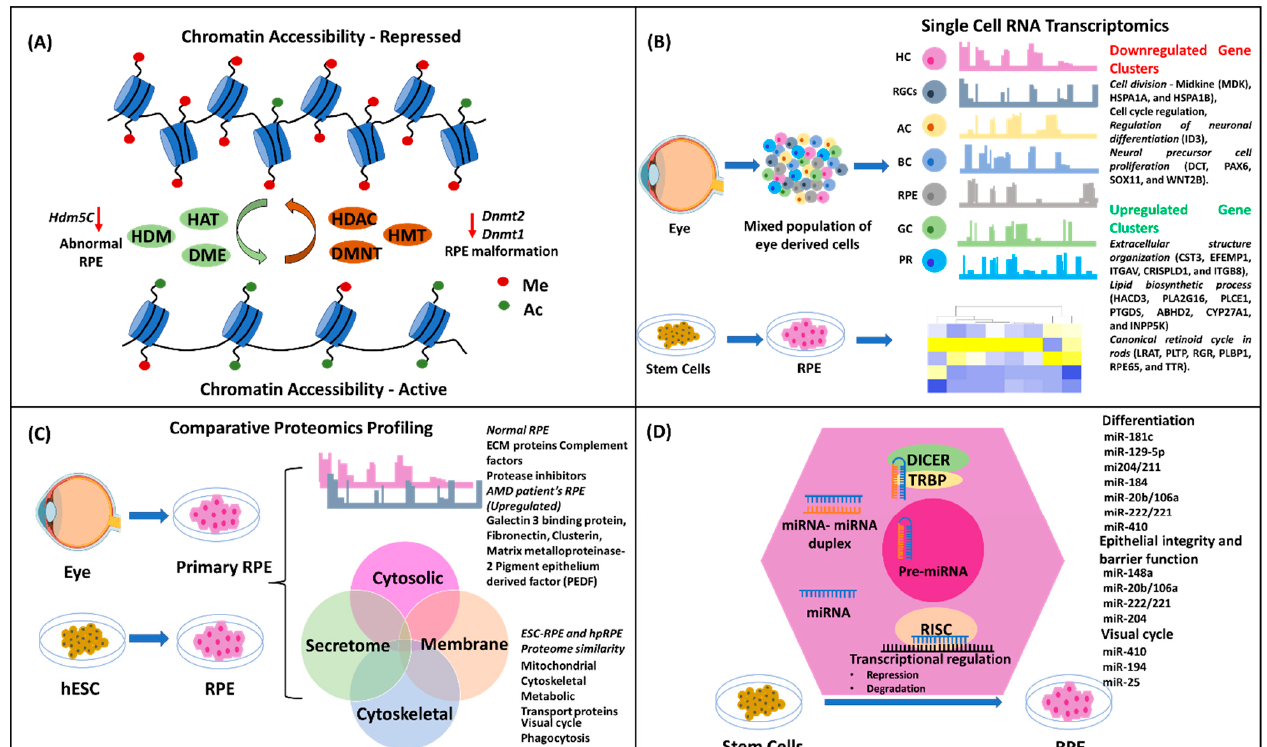
Figure 3. Schematic representation of the genetic and molecular regulation of RPE development and differentiation. ( A ) Epigenetic regulation controlling the RPE development. ( B ) Transcriptomics of the RPEs originating from primary cells isolated from humans, and stem cell-derived RPEs. ( C ) Comparative proteomic profile of the human RPEs and ESC-/iPSC-derived RPEs. Proteomes of various fractions (cytosolic, membrane, cytoskeletal, and secretome) display similarity when compared to primary and ESC-derived RPEs. ( D ) MicroRNA biogenies and their role in the development and differentiation of RPEs derived from stem cells. Various microRNAs have been shown to play a critical role in various stages of RPE development and physiological function. HDM—Histone